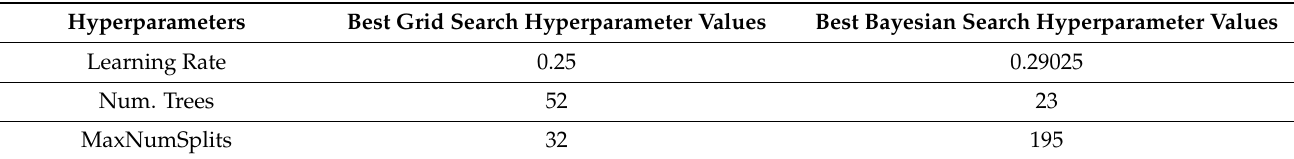
Figure 7. Cross-validated MSE curves arising from hyperparameter tuning. Table 3. Optimal hyperparameter values using grid search and Bayesian search.